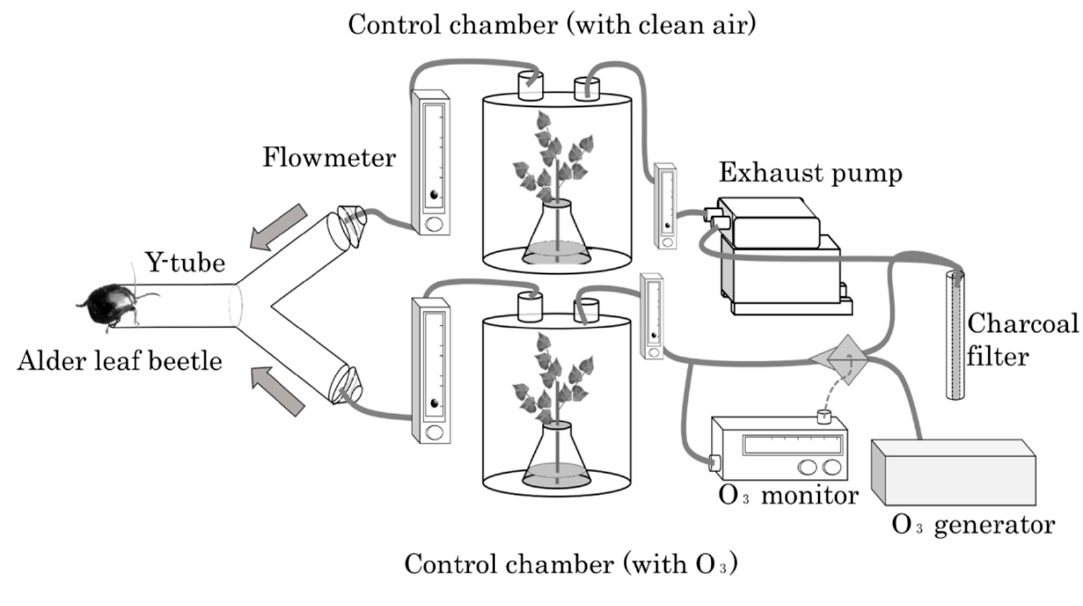
Figure 1. Olfactory response test (Y-tube preference test). Each arrow in this figure indicates the aerial direction.